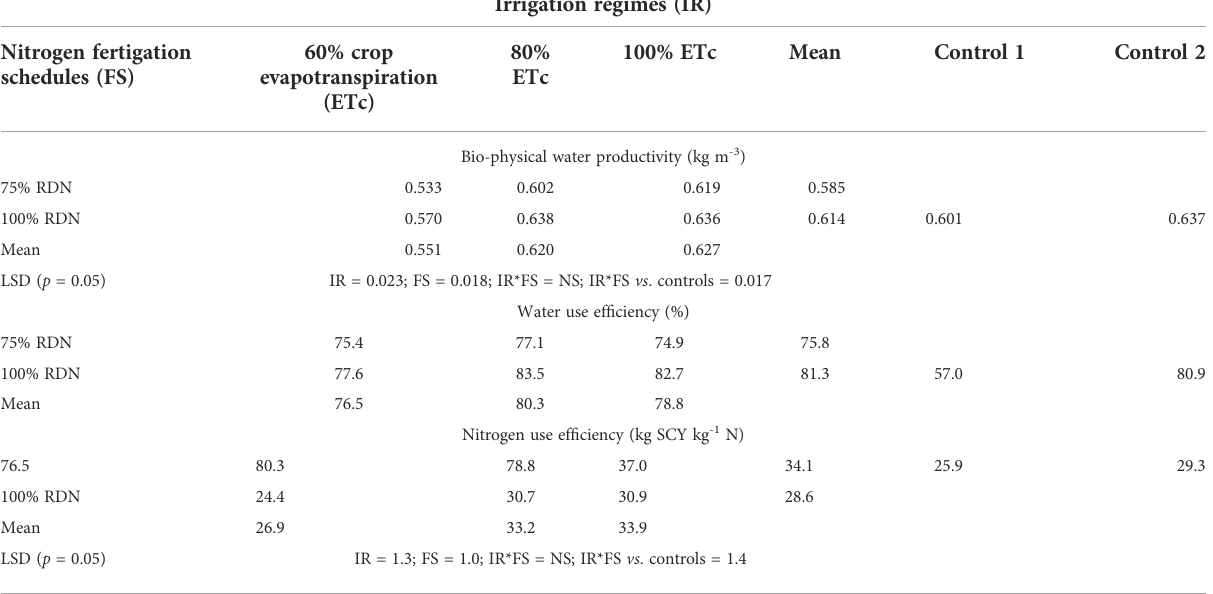
Irrigation regimes (IR)